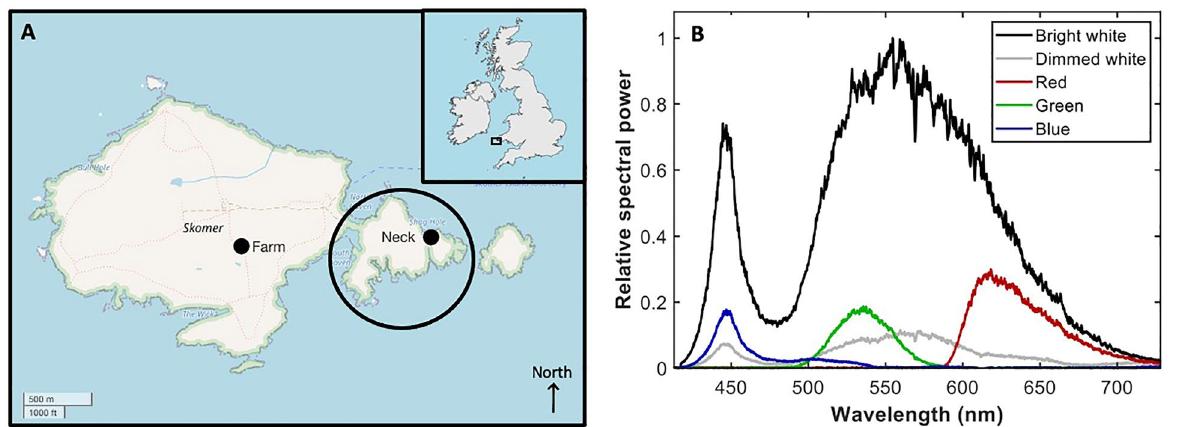
Figure 1. ( A ) Map of Skomer Island indicating the locations of the experiment on the Neck (right) and near to the farmhouse (the Farm, left) using black dots. The area that tourists are not allowed to access is encircled in black (OpenStreetMap, 2020). ( B ) Spectra of the light sources used in the experiment showing wavelength- dependent intensity of the light source employed depending on the filter in place to produce the light sources required; namely red, green, blue, dimmed white, and bright white. The flux for the torch covered with the red (4.3 W), green (2.0 W), and blue (1.4 W) filter as well as for dimmed white (1.4 W) was of the same order of magnitude, with an average value of (2.7 ± 1.3) W. The flux for the torch without a filter was ten times greater (32